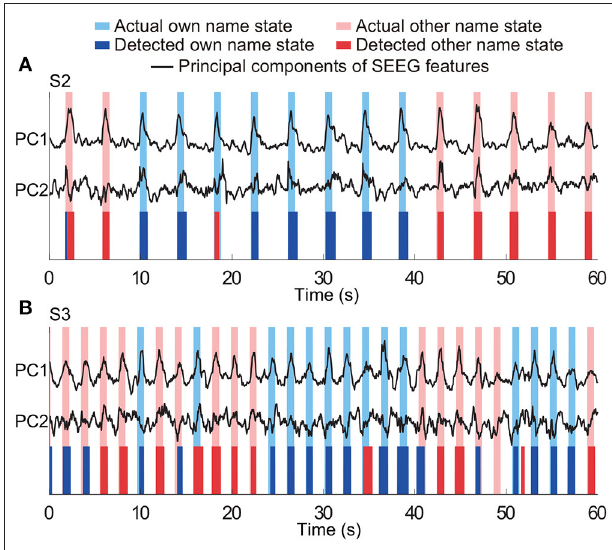
FIGURE 12 | Representative results of three-class (own name, other name, and idle) state detection. Periods with white indicate the actual and detected idle states. Panels (A,B) are the results from two typical subjects (S2 and S3). The traces of principal components of SEEG features were normalized.